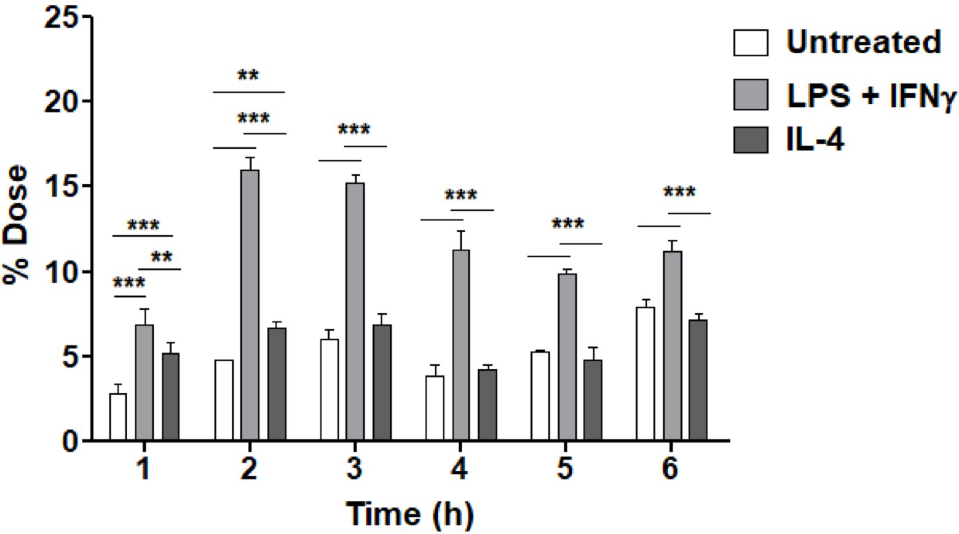
Fig 6. Cell uptake of 99m Tc-HYNIC-dendrimer-mannose-Cy7. BMDMs untreated and treated with LPS + IFN γ and IL- 4 were incubated with 99m Tc-HYNIC-dendrimer-mannose-Cy7. Cellular uptake was analyzed 1 to 6 hours after incubation. Data are expressed as % dose (mean ± SD). A comparison in each group was performed by two-way ANOVA followed by the Bonferroni test ( ��� p < 0.001, �� p < 0.01 and ns = p > 0.05).